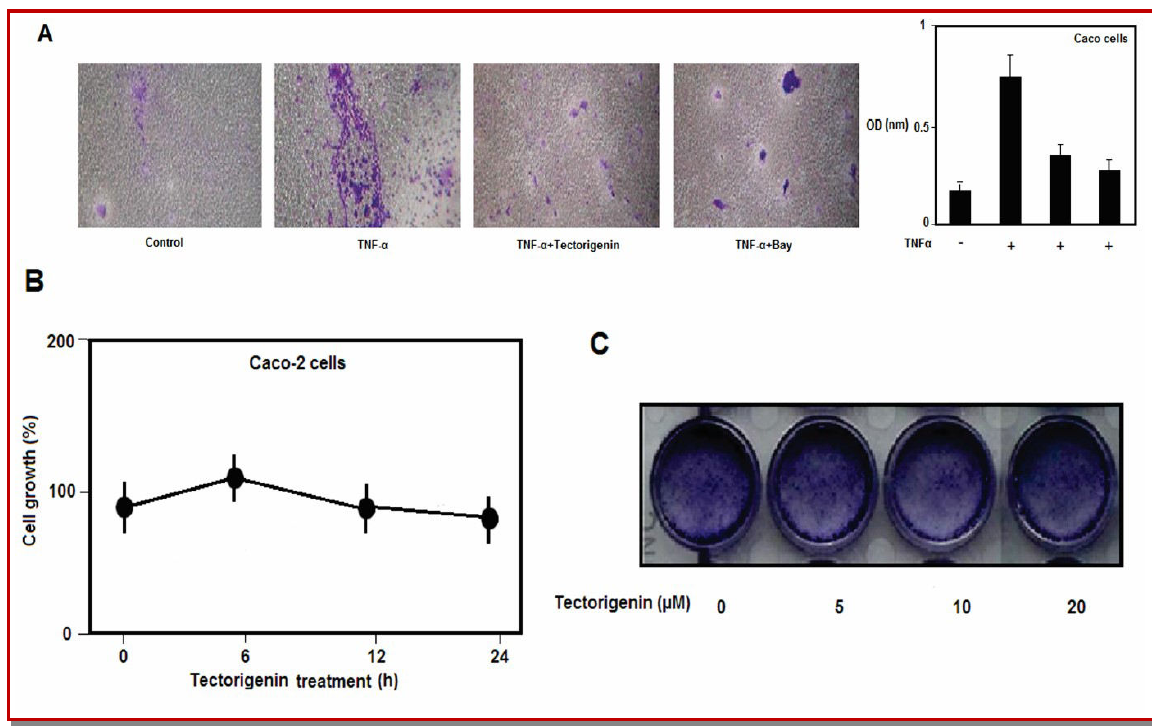
Figure 2: Tectorigenin inhibitory effect on TNF- α induced invasive studies (A) Treatment of Caco-2 cells with 10 ng/mL TNF- α in the presence or absence of tectorigenin (20 µM)/ BAY11-7082 (20 µM). (B) Tectorigenin (20 µM) treatment with Caco-2 cells in different time periods (6-24 hours). (C) Caco-2 cells treated with different concentrations of tectorigenin (0, 5, 10 or 20